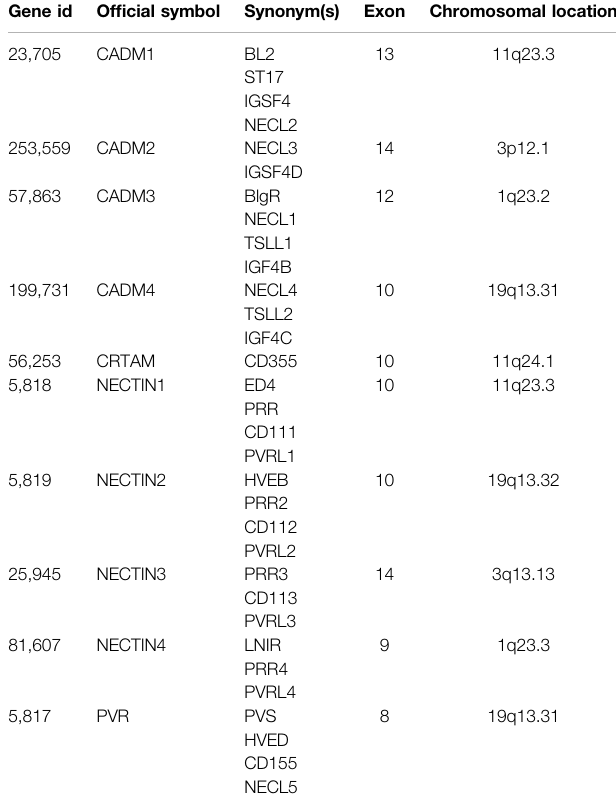
TABLE 2 | Basic characteristics of NECTIN family